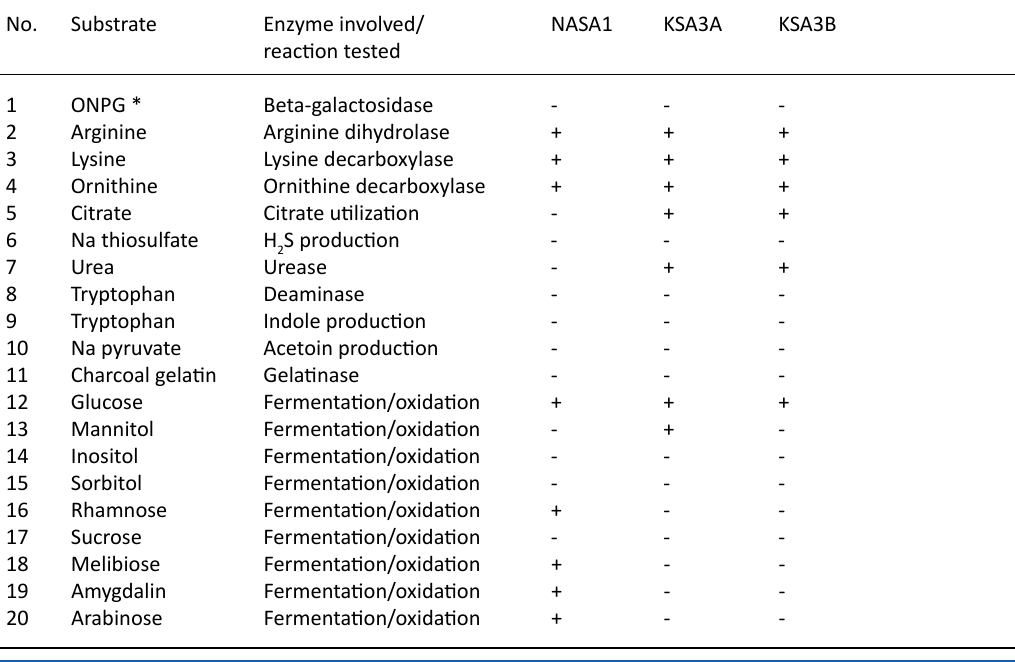
Table 2. Results of the API 20 NE kit